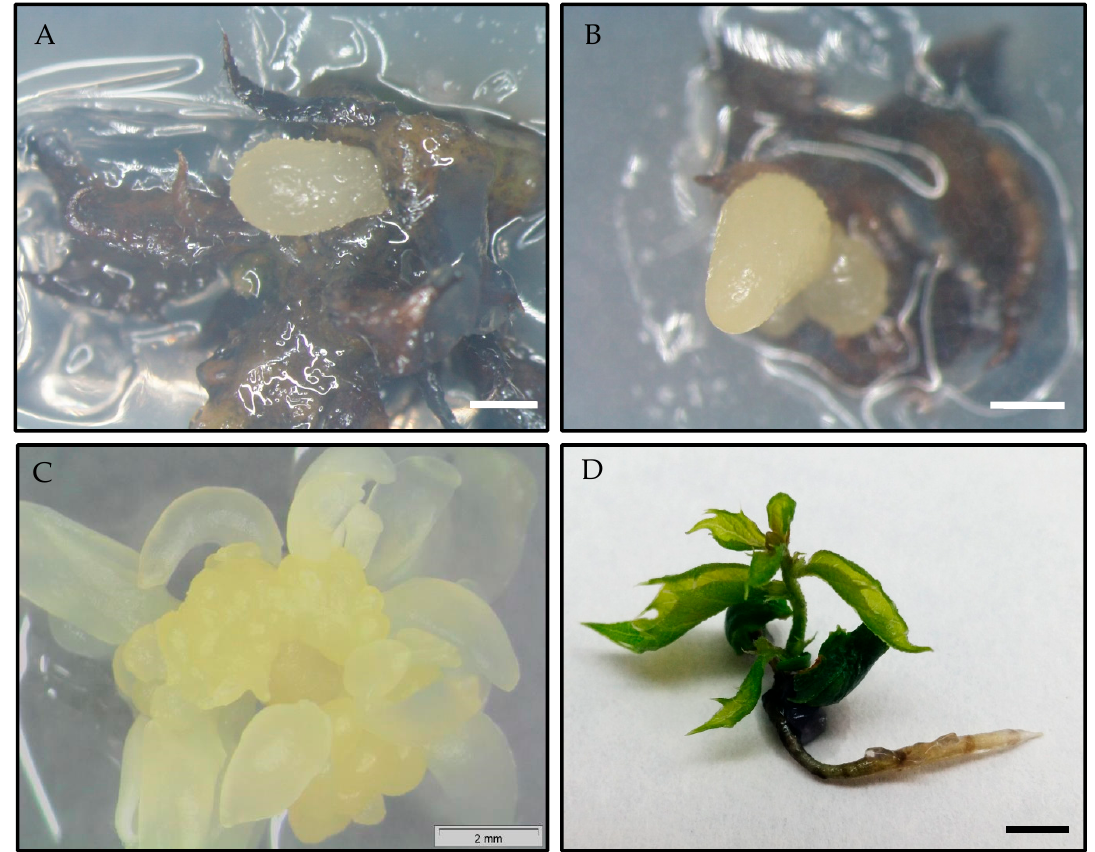
Figure 3. Somatic embryogenesis from shoot apex explants excised from axillary shoot cultures derived from disease-tolerant holm oak plants. ( A , B ). Somatic embryos initiated in shoot apex explants of genotype PR9. ( C ). Repetitive embryogenesis after six weeks of subculture of embryogenic nodular structures (NSs) on proliferation medium ( D ). Plant regeneration from stratified somatic embryos after six weeks on germination medium. Scale bar: ( A , B ) = 1 mm; ( D ) = 1 cm. Table 7. Effect of genotype and auxin treatment on embryogenic response in shoot apex explants derived from axillary shoot cultures of three tolerant Quercus ilex genotypes.